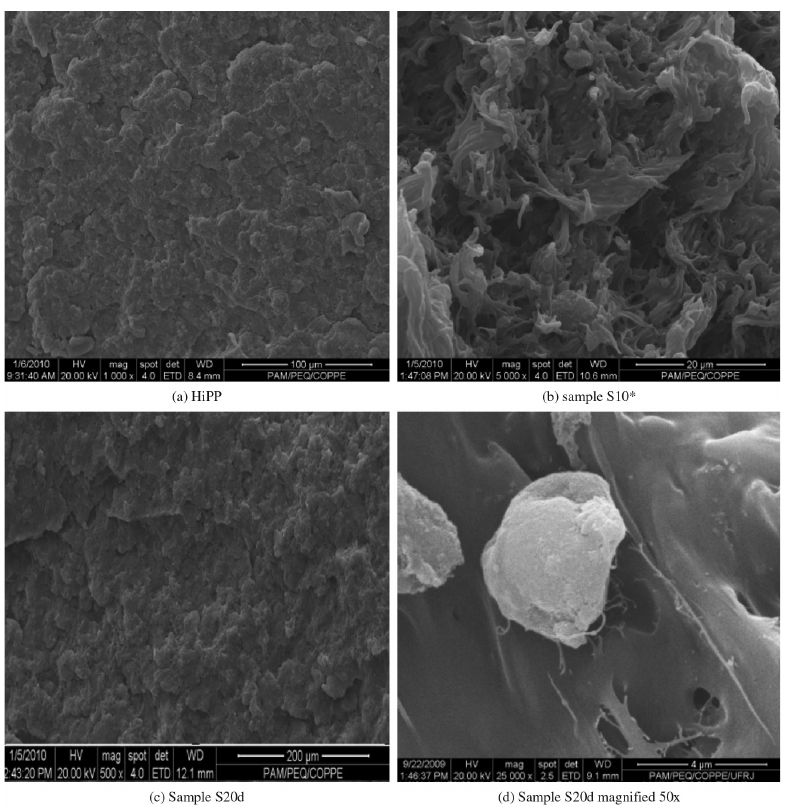
Figure 3. SEM images: (a) hiPP, (b) Composite S10* (with untreated silica), (c) Composite S20d (20% w/w silica, with DCP), (d) Composite S20d Table 2. Extraction with hexane of the pure hiPP and their composites with silica.